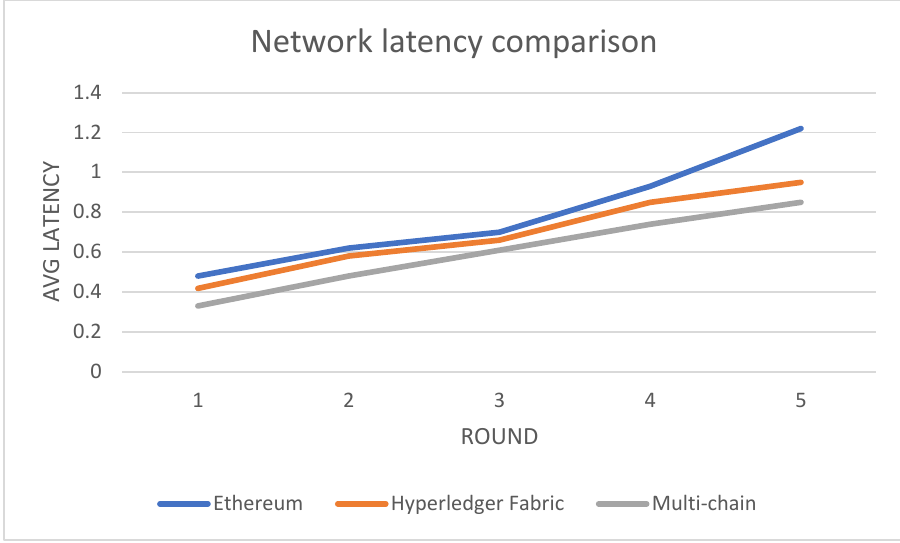
Figure 32. Comparison of three types of network transaction latency performance.